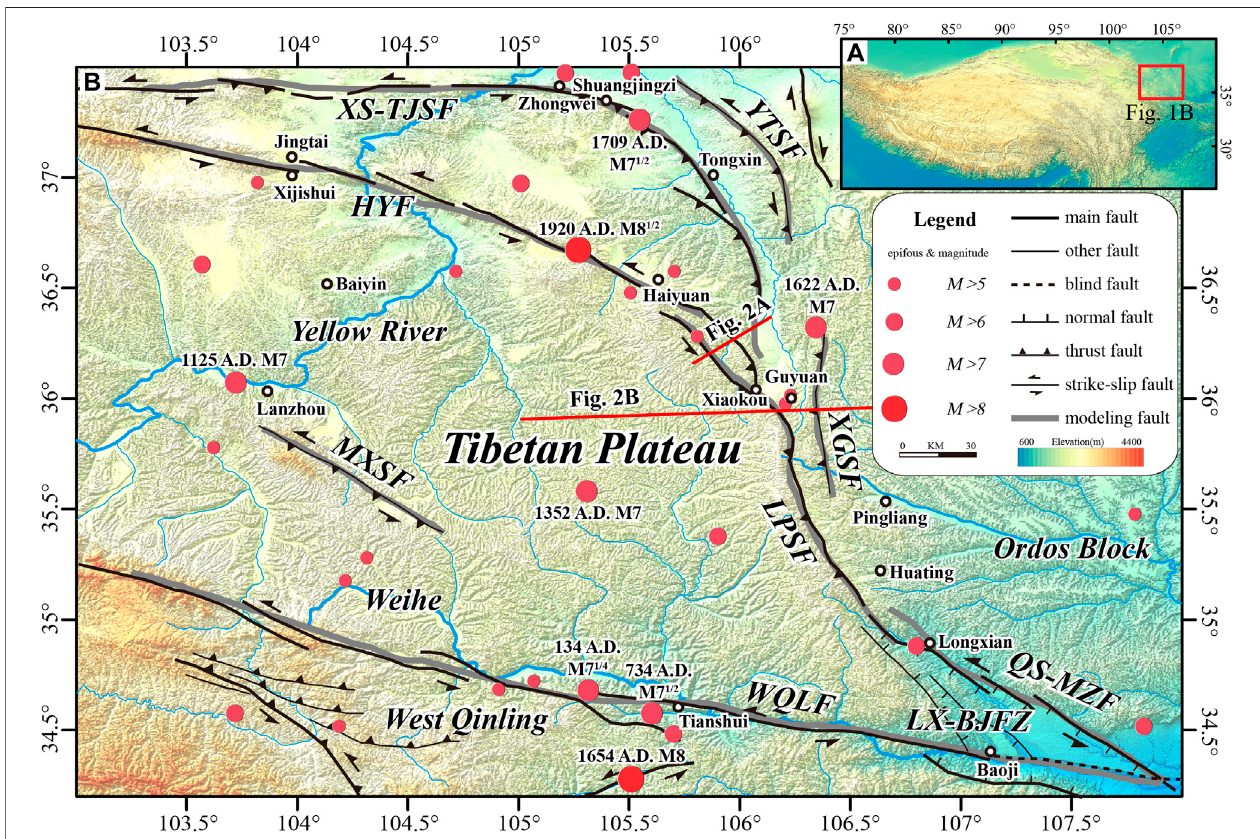
FIGURE1| Topographyandmajoractivefaultsinthearc-shapedtectonicbeltinthenortheasternmarginoftheTibetanPlateau[modi fi edfromZhengetal.(2016); Zheng et al. (2019)]. The major main faults are shown as fi ne black lines, whereas the modeling faults are shown by thick gray lines. Recorded historical earthquakes (i.e., M ≥ 5) are shown as red circles [modi fi ed from Zheng et al. (2019)] The locations of pro fi les ( Figures 2A,B , solid red lines) are indicated. XS-TJSF, Xiangshan- Tianjingshan fault;HYF, Haiyuan fault;YTSF, Yantongshan fault;XGSF, Xiaoguanshan fault;LPSF, Liupanshan fault;MXSF, Maxianshanfault; WQLF,West Qinling fault; QS-MZF, Qishan-Mazhao fault; LX-BJFZ, Longxian-Baoji fault zone (The following abbreviations have the same meaning).